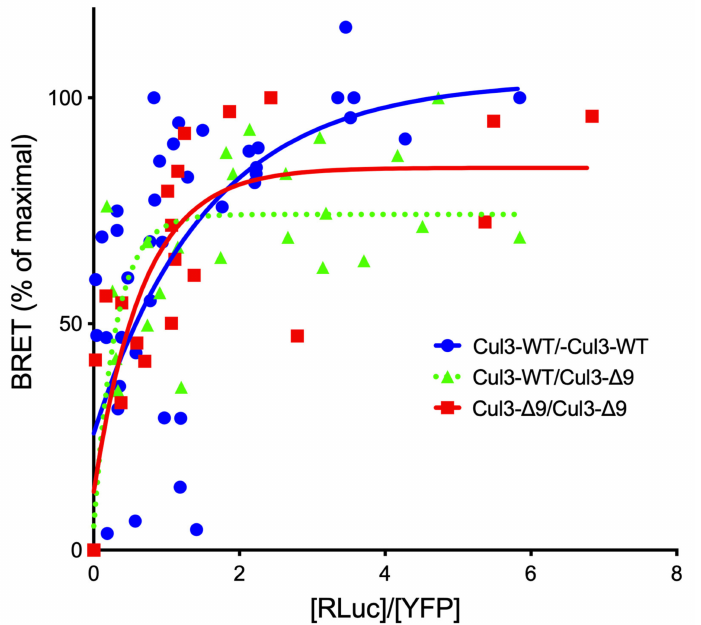
Figure 2. Dimerization of CUL3-WT and CUL3- ∆ 9. CUL3-WT and CUL3- ∆ 9 were tagged with luciferase or YFP at their C- or N-terminus and expressed in HEK293 cells. BRET signals between the donor constructs (CUL3-Luc and Luc-CUL3- ∆ 9) and increasing amounts of the acceptor constructs (YFP-CUL3 and YFP-CUL3- ∆ 9) were measured using a Mithras LB 940 multimode reader (Berthold). The results are expressed as percentages of the maximal BRET signal ( Y ) as a function of the Luc/YFP concentration ratio ( X ). Similar hyperbolic curves were observed for CUL3-WT and CUL3- ∆ 9 ho- modimerizations and CUL3-WT/ ∆ 9 heterodimerization. BRET 50 values, which reflect the affinity between the two interactors, were 0.24 ± 0.1 ( n = 4), 1.27 ± 0.42 ( n = 3), and 0.45 ± 0.24 ( n = 3) for WT/WT, ∆ 9/ ∆ 9, and WT/ ∆ 9, respectively (non-significant differences except for WT/WT